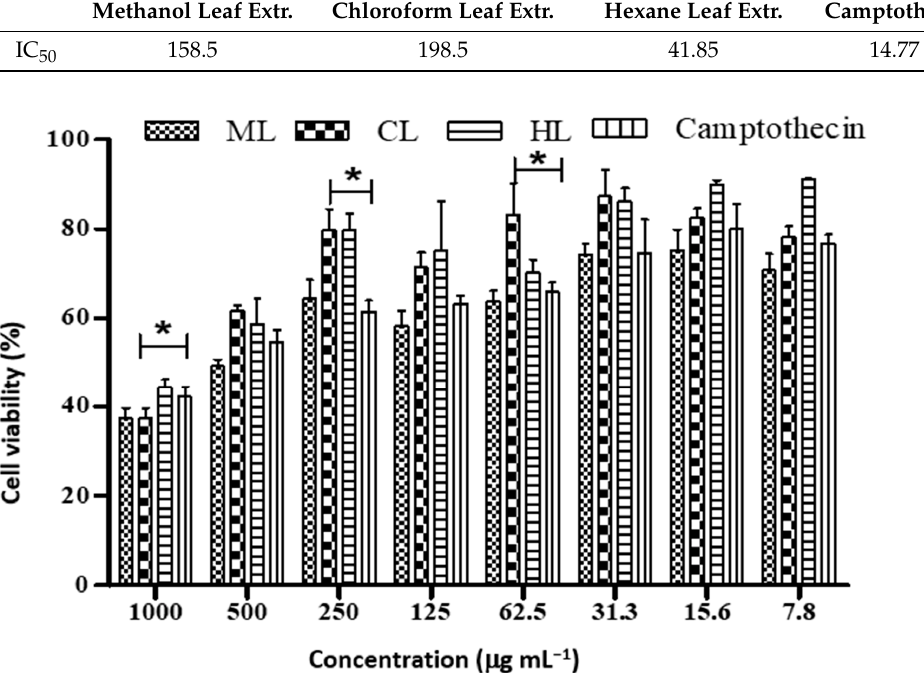
Figure 4. Cell viability of HEK293 cancer cell lines treated with different concentrations of D. villosa leaves extract. * (ML vs. Camptothecin); * (CL vs. camptothecin), p < 0.05.